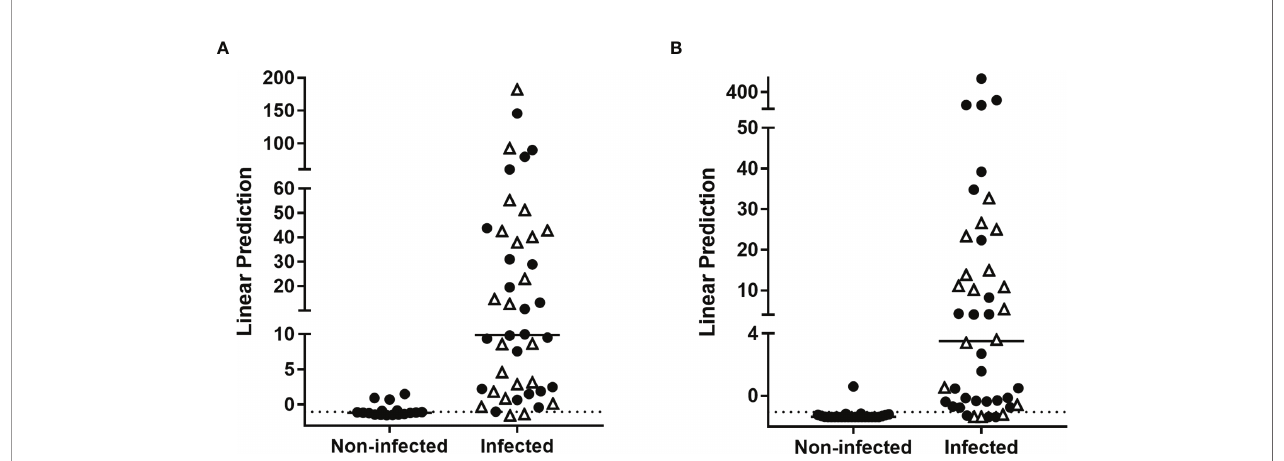
FIGURE 4 | Combination of M. tuberculosis -speci fi c immune markers allowing the distinction between M. tuberculosis -infected versus non-infected subjects in the WB assay. HBHA-IFN- g and ESAT-6-IFN- g were the markers selected by logistic regression analysis to be combined for the WB-based assay to discriminate M. tuberculosis -infected from non-infected subjects. Patients with aTB are indicated by open triangles. Results are represented with their linear predictor for the validation (A) and training (B) cohorts. The horizontal lines represent the medians and the dotted lines arbitrary